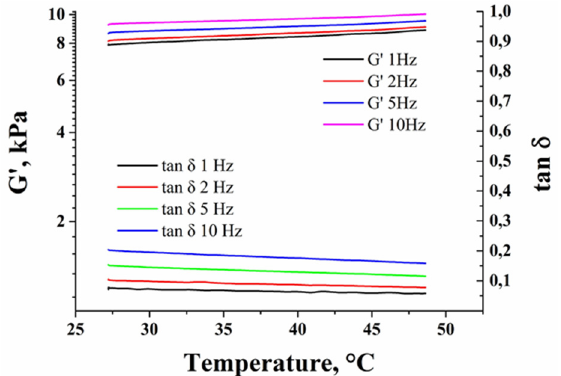
Figure 19. Temperature dependence of shear modulus and loss tangent at different shear rates for Nanoembosil ® . Reprinted with permission [68]. Copyright 2021, Elsevier.